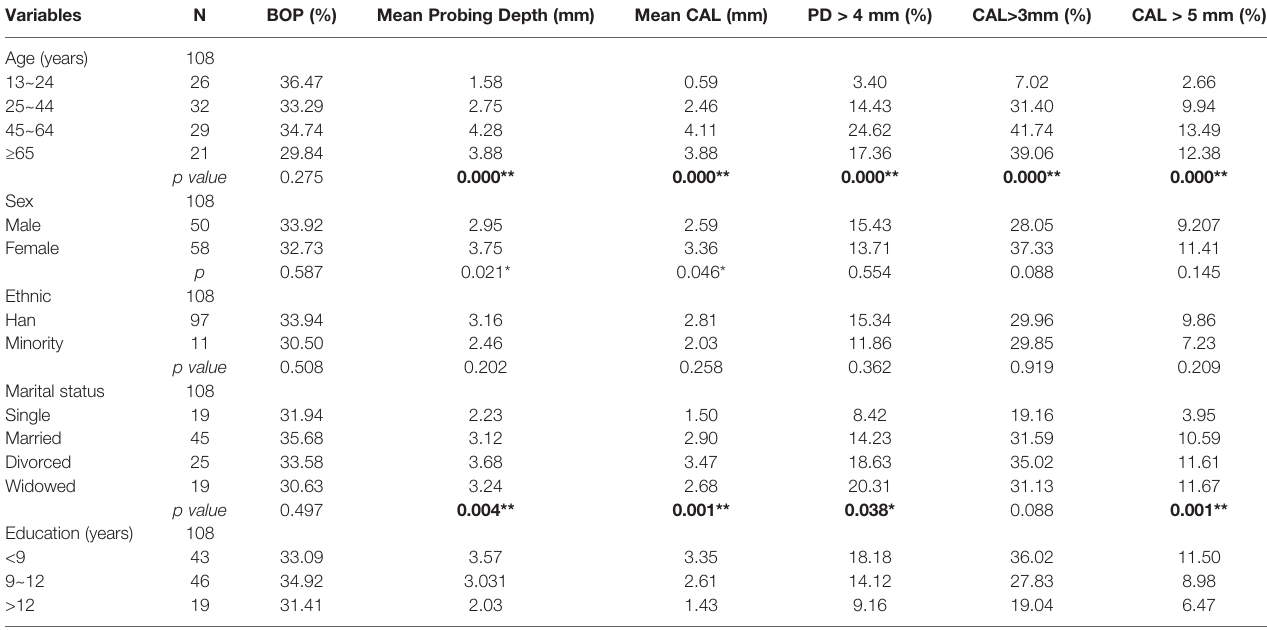
TABLE 1 | Comparison of demographic variables with periodontal health status in HIV-infected patients, n = 108.